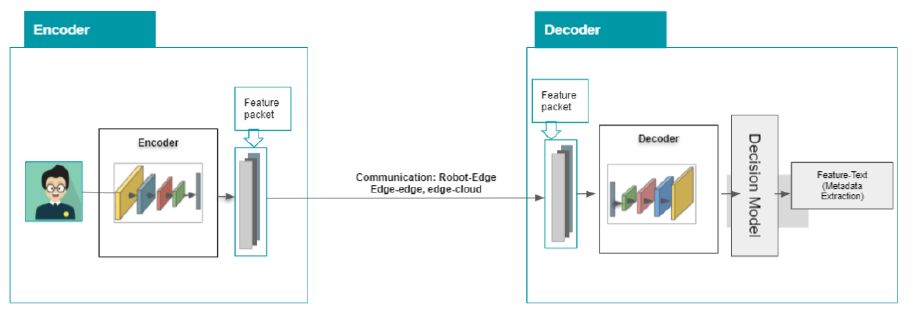
Figure 6. Encoder–decoder example for transferring the encoded features of images instead of actual